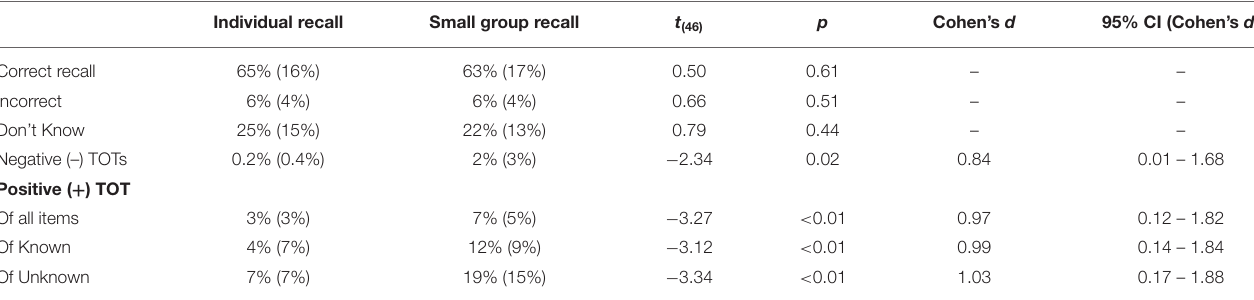
TABLE 5 | Mean (standard deviation) percentages of correctly recalled items, incorrect and “Don’t Know” responses, negative and positive TOT indexes, by recall condition, after removing trials with verbal exchanges (21% of TOTs).